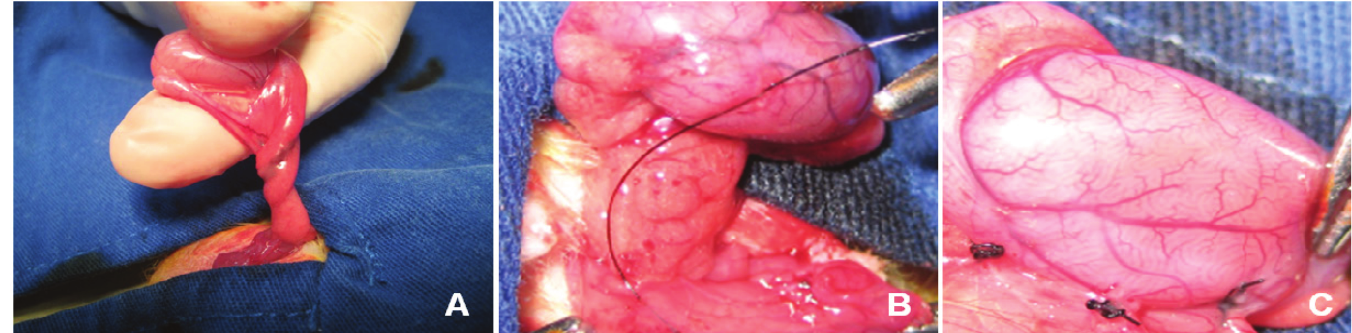
FIGURE 1 - Photographs of the experimental group: A ) Left testicular torsion of 1.080 degrees in a counterclockwise direction, B ) 5/0 polyamide monofilament suture, placed through the testicular albuginea and medial scrotal wall, to fix the left twisted testis, C ) Three fixation stitches of the torsion (black